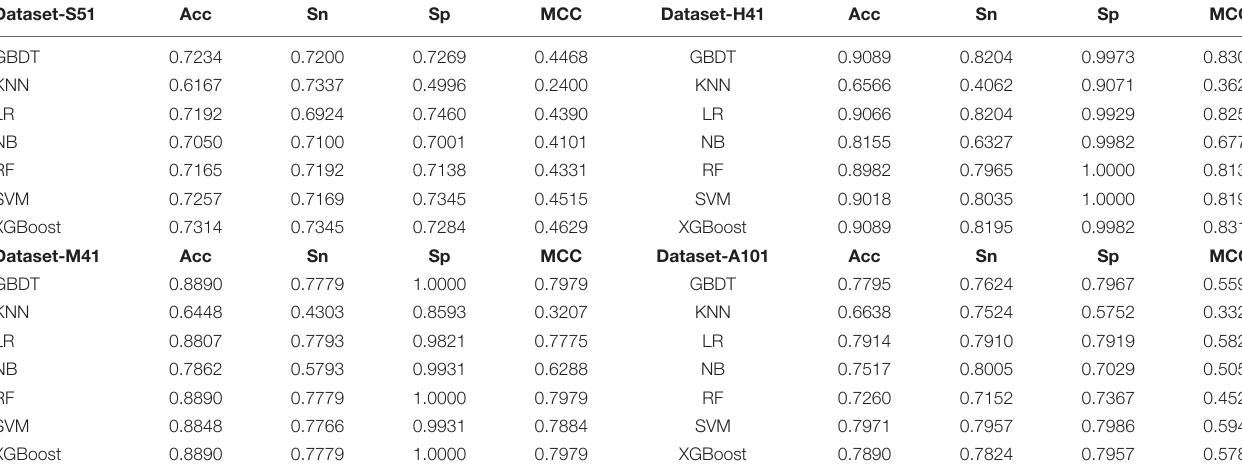
FIGURE 3 | Performance of XGBoost and other classifiers on four benchmark datasets. TABLE 2 | Performances of XGBoost and other machine learning algorithms.